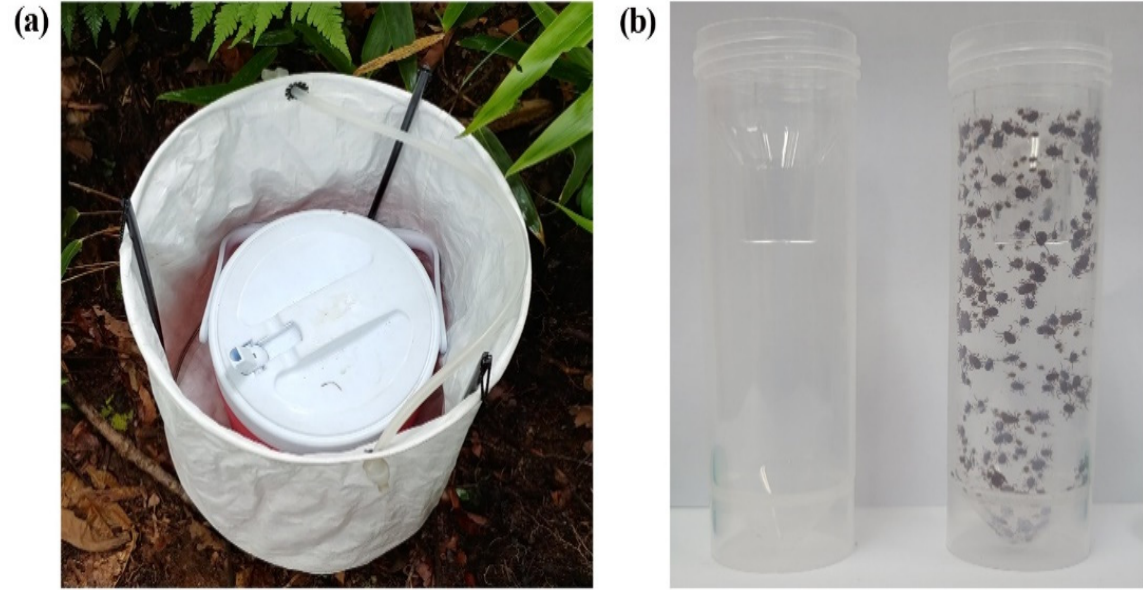
Figure 2. Dry ice bait collecting trap ( a ), which consists of a tarpaulin cylindrical trap and a cylindrical ice chest, installed at each environmental point and ( b ) a tick collection tube that prevents the escape of ticks.